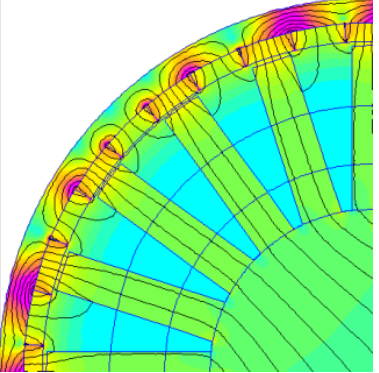
Figure 2. Finite Element Method (FEM) model of a TFM machine used to calculate flux changes during rotor rotation.